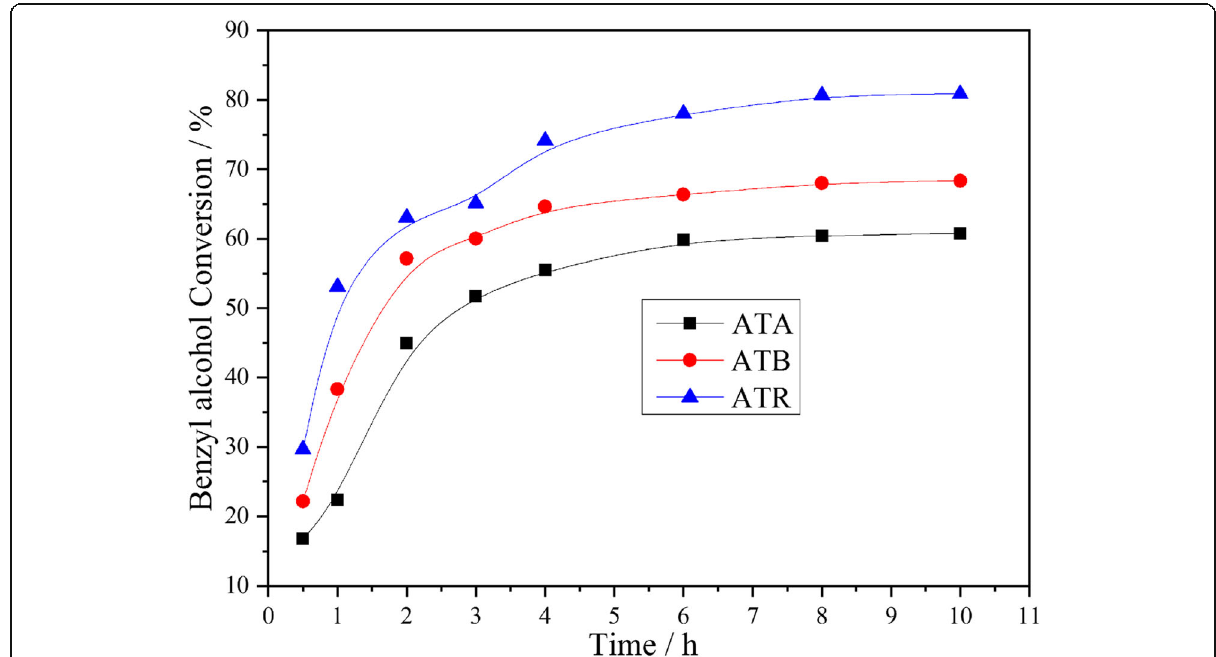
Fig. 4 Benzyl alcohol conversion as a function of time achieved on the ATA, ATB, and